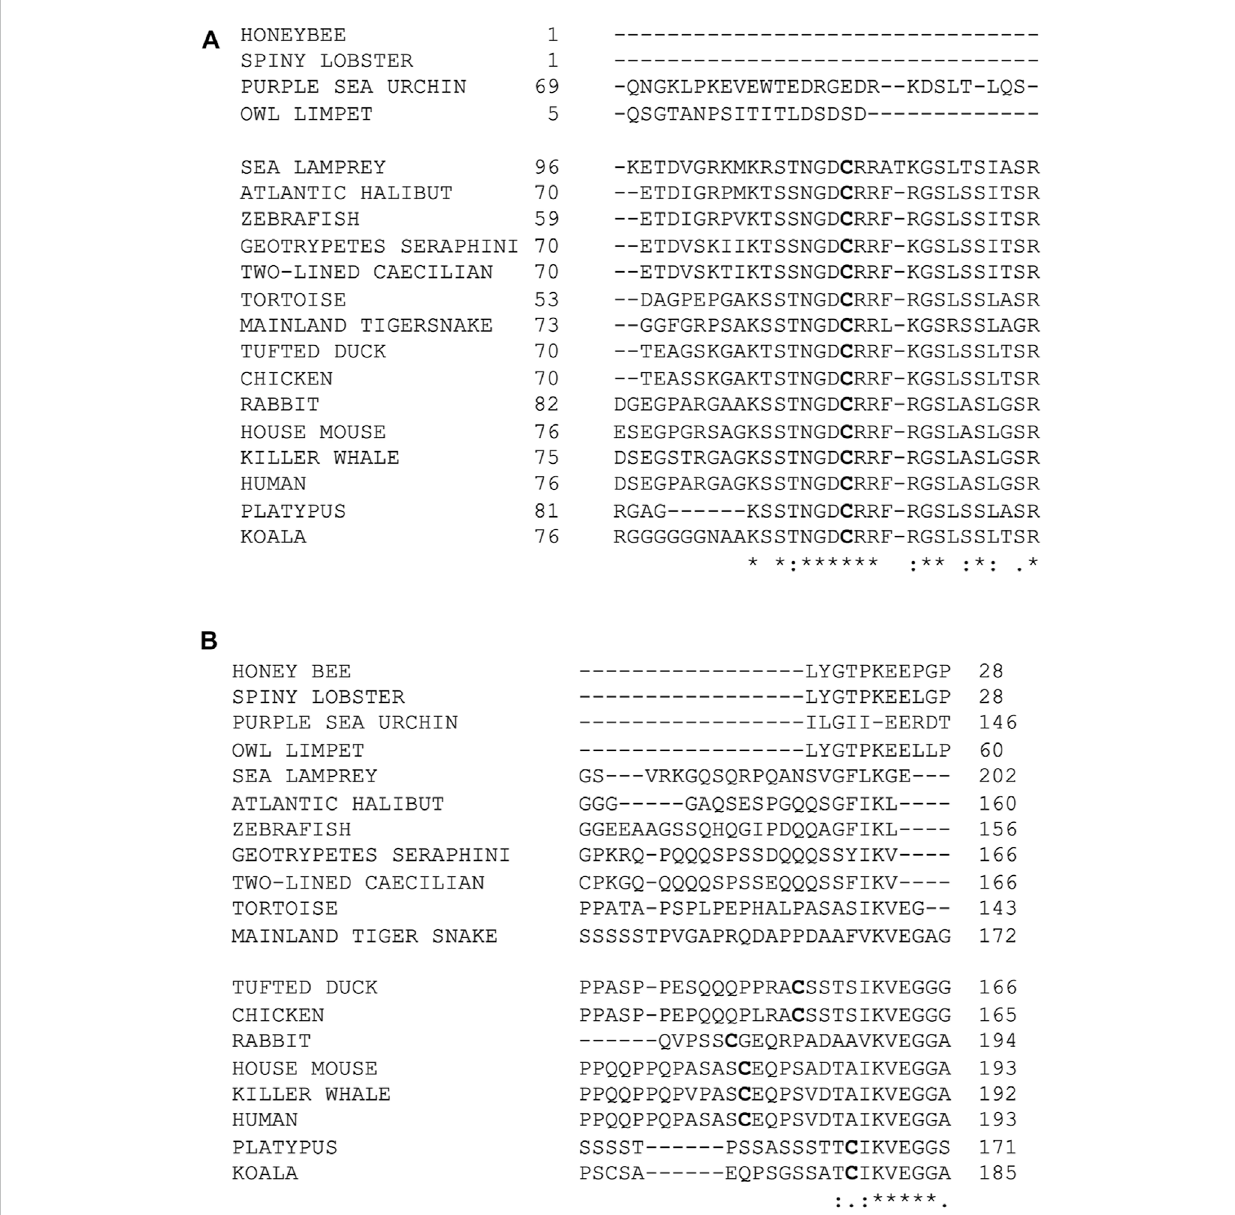
Conservation of palmitoylation sites amongst HCN4 homologues. (A) Conservation of cysteine 93. Alignment was generated using Clustal Omega. Palmitoylation site C93 and analogous cysteines are highlighted in bold. C93 is conserved in all vertebrates. The sequence surrounding C93 includes the cassette SSTNGDCRRFKGSLSSLTSR which is uniquely conserved amongst the vertebrates. (B) Conservation of cysteine 179. Alignment was generated using Clustal Omega. Palmitoylation site C179 and analogous cysteines are highlighted in bold. C179 is conserved in mammals and birds only. “ * ” below an amino acid indicates 100% conservation between isoforms; “ : ” indicates amino acids of highly similar properties; “ . ” indicates amino acids of weakly similar